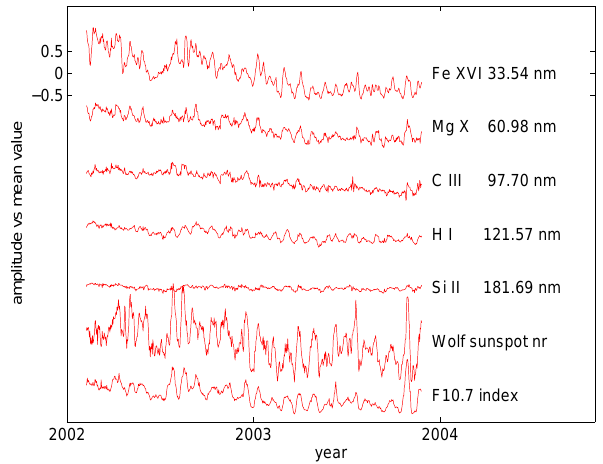
Fig. 1. Time evolution of five spectral lines (as measured by TIMED) and two proxies for solar activity. All time series are nor- malised to their time average. Note that the 27-day modulation, caused by solar rotation, has a much larger amplitude in the coronal Fe XVI line than in the chromospheric Si II